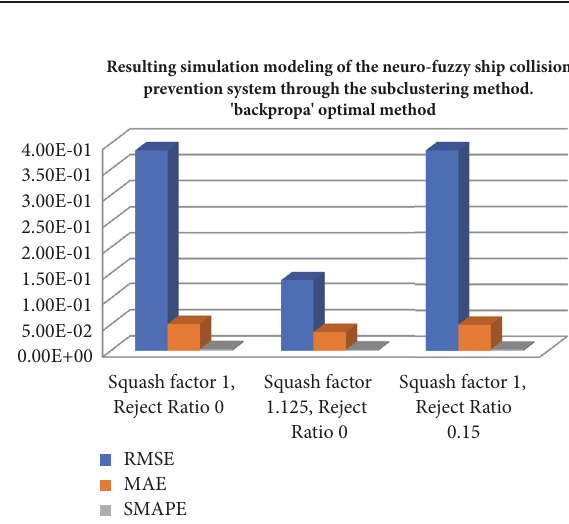
Figure 4: Resulting qualitative evaluation in the neural-fuzzy ship collision prevention system training when generating by the subclustering method through backpropagation error algorithm.